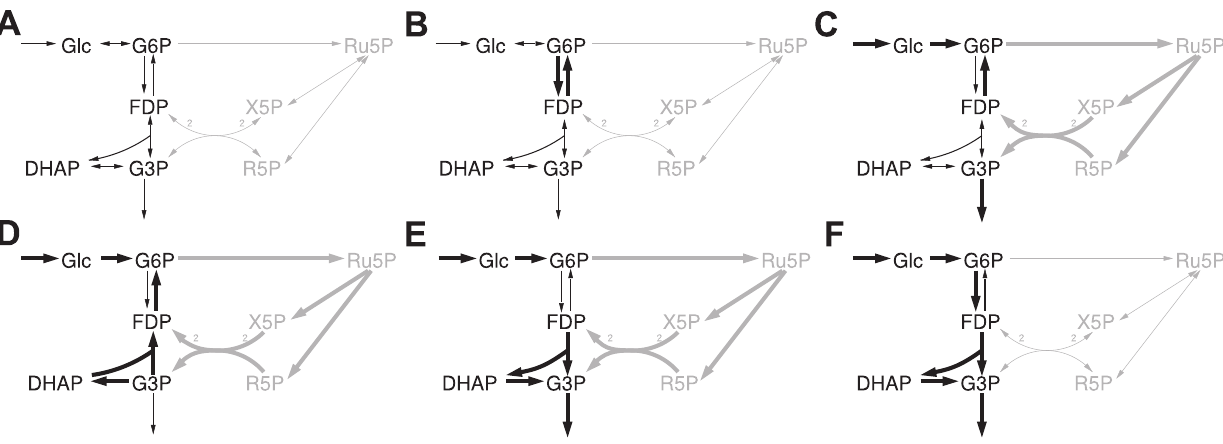
Figure 2. Examples of elementary flux patterns. A Schematicnetworkof upper glycolysis andthepentose phosphatepathwaywithcorresponding elementary flux patterns. Reactions of the subsystem are drawn in black. B–F Elementary flux patterns of the system. Thick black arrows correspond to the reactions of each flux pattern in the subsystem. Thick gray arrows indicate the reactions used by an elementary mode of the entire system using the reactions of the flux pattern in the subsystem. Individual flux ratios have been omitted for clarity. A list of abbreviations can be found in Table S1.